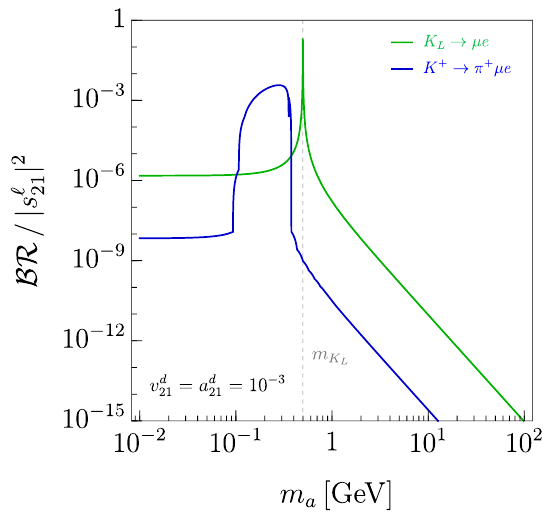
2 (blue line) and Figure 11 . ( K + (cid:25) + (cid:22)e ) = s ‘ 21 j B ! j against m a . The ALP couplings to quarks are taken to be v d width is (cid:12)xed to (cid:0) a = 10 (cid:0) 6 GeV for illustration. Di(cid:11)erent values of (cid:0) a would imply a shift of the semileptonic rate in the resonant region.